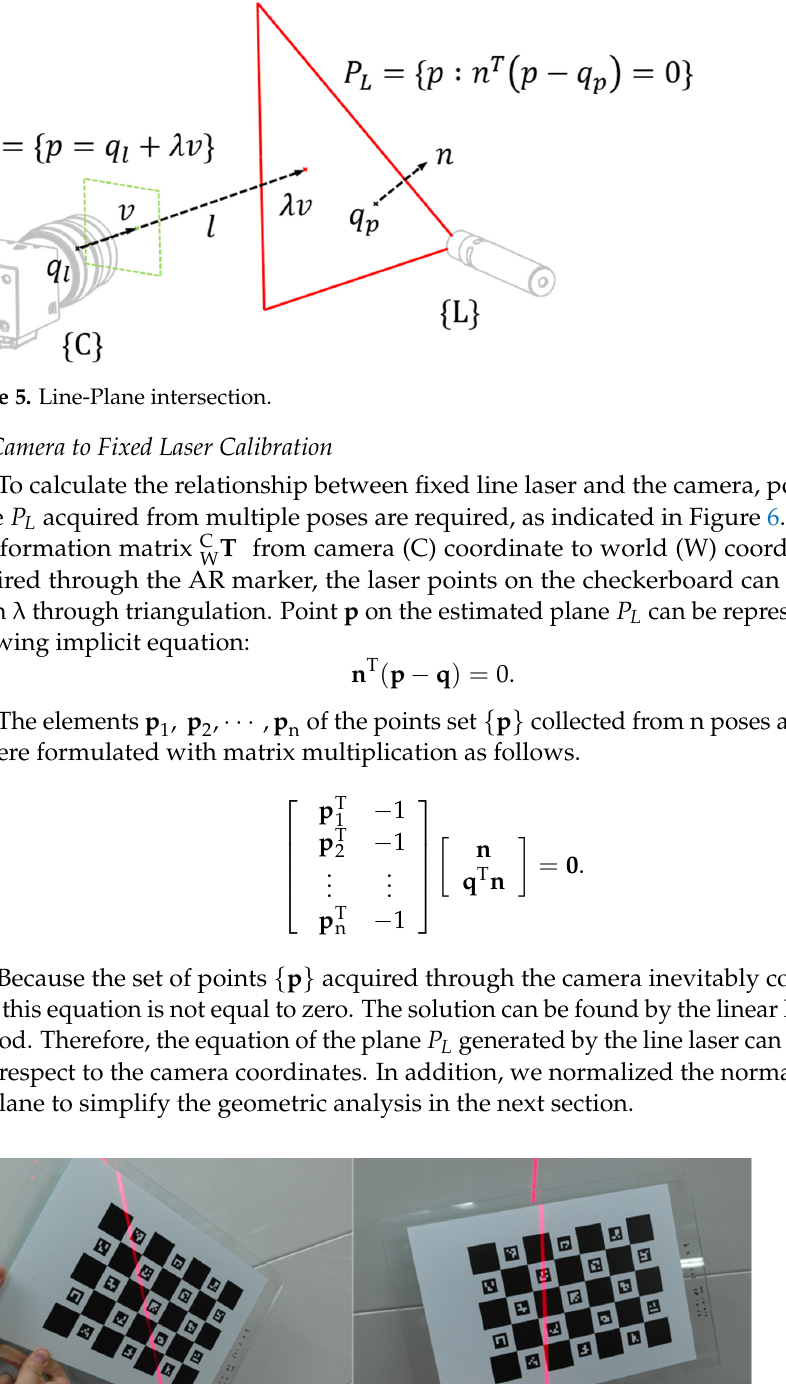
Figure 6. Calibration of laser plane with respect to camera coordinate.